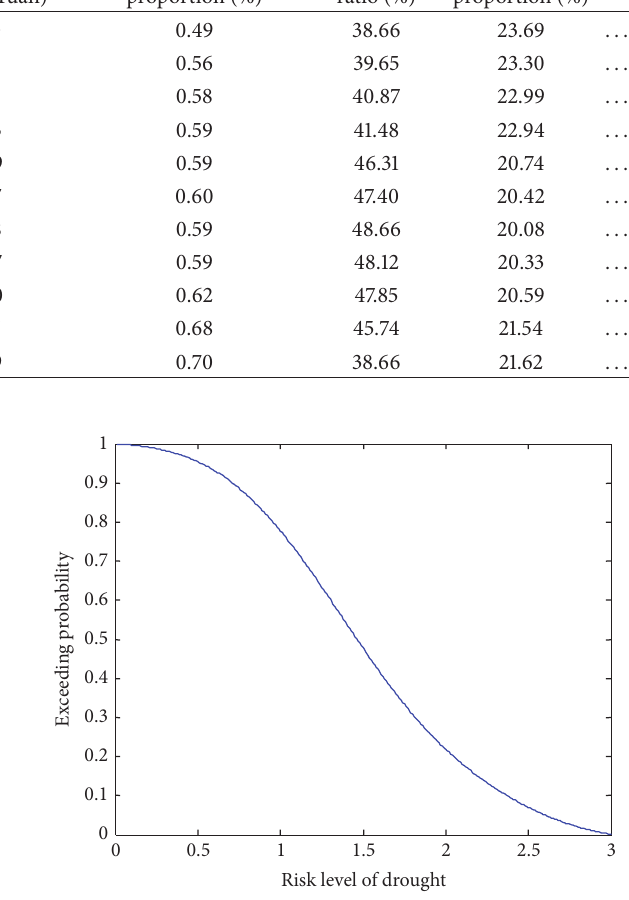
Figure 5: The exceeding probability curve of drought to drought risk level in